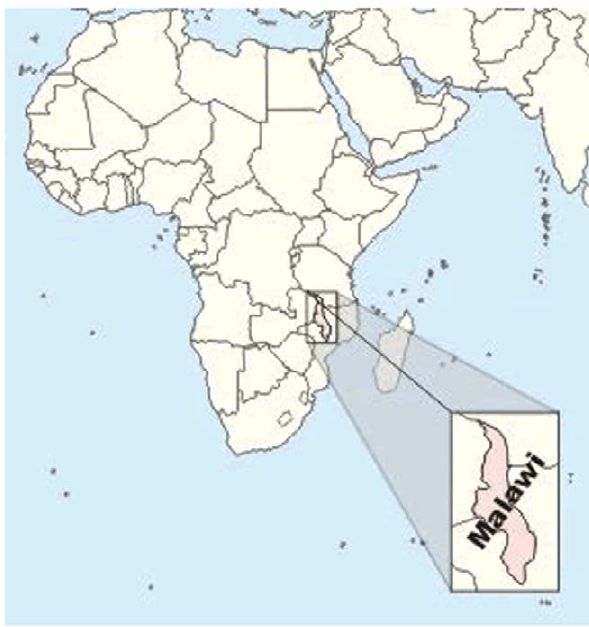
Figure 1. Map of Malawi in Africa. (source: http://www.un.org/ depts/Cartographic/map/profile/malawi.pdf).